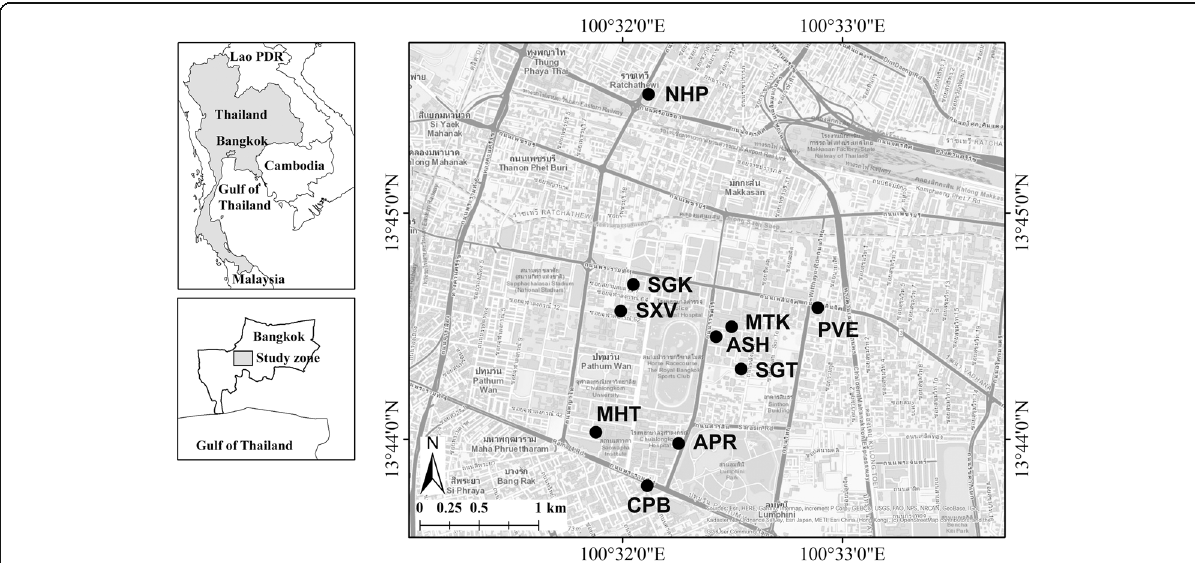
Fig. 1 Location of the ten green roofs in this study ( APR Aor Por Ror Building, ASH Anantara Siam Bangkok Hotel, CPB Crowne Plaza Bangkok Lumpini Park Hotel, MHT Mahitaladhibesra Building, MTK Mitkorn Mansion, NHP Noble House Phayathai, PVE Park Venture Ecoplex, SGK Siam Green Sky, SGT SG Tower Building, and SXV the 60th Anniversary